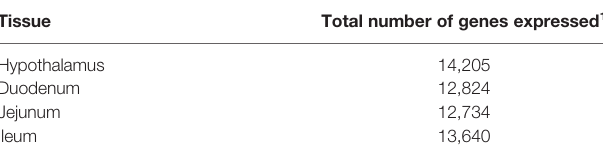
TABLE 3 | Summary of expressed genes by